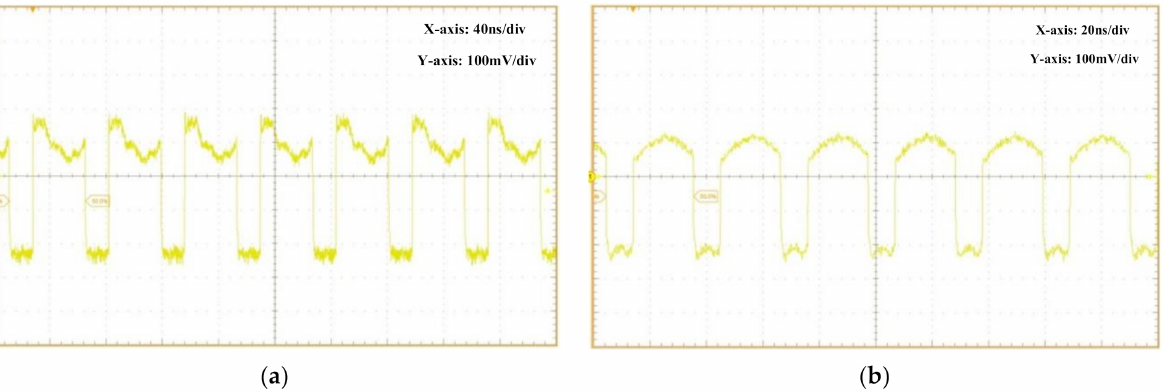
Figure 10. Measured output waveforms of the improved programmable frequency divider: ( a ) fin = 12 GHz, n = 648; ( b ) fin = 19 GHz, n =